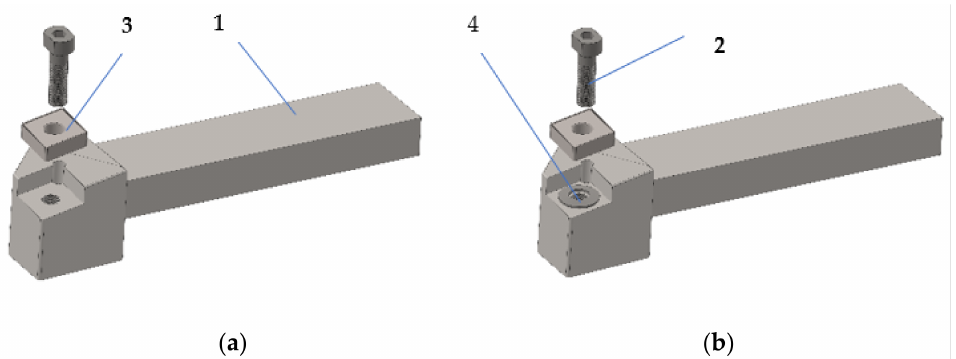
Figure 1. Tools for front turning: ( a ) in the classic version (T01); ( b ) with an improved constructive shape (T02), 1—the body of the tool; 2—screw of fixing; 3—removable plate, 4—elastic